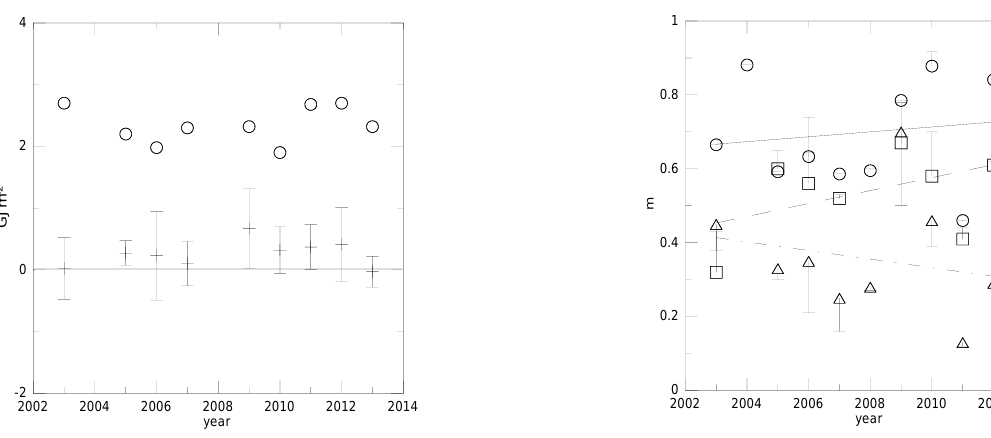
Figure 2. Total annual surface energy balance ( R n − G − LE − H ) compared with the measured annual net radiation ( R n , circles).